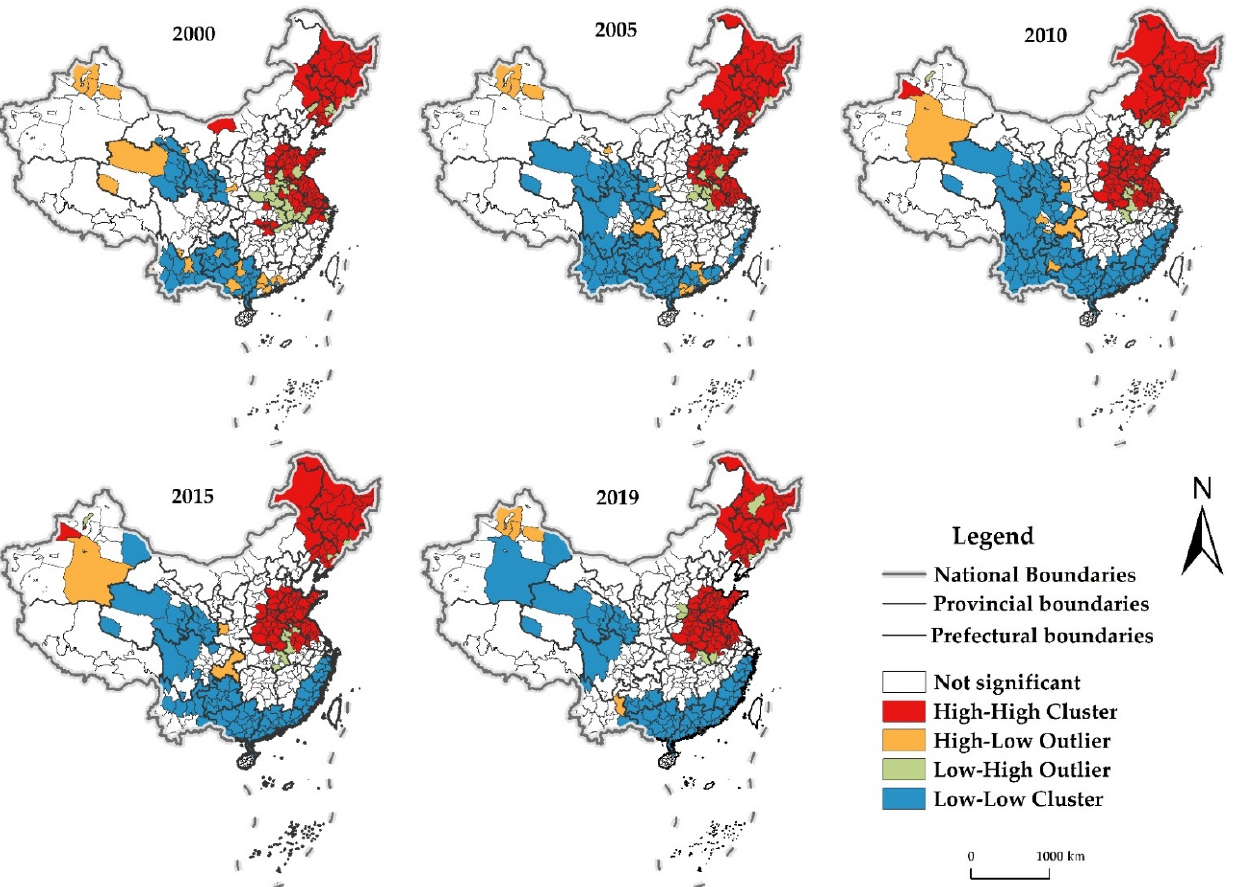
Figure 3. LISA distribution of CDUFS. Note: This figure is drawn by the authors themselves using ArcGIS based on the calculation